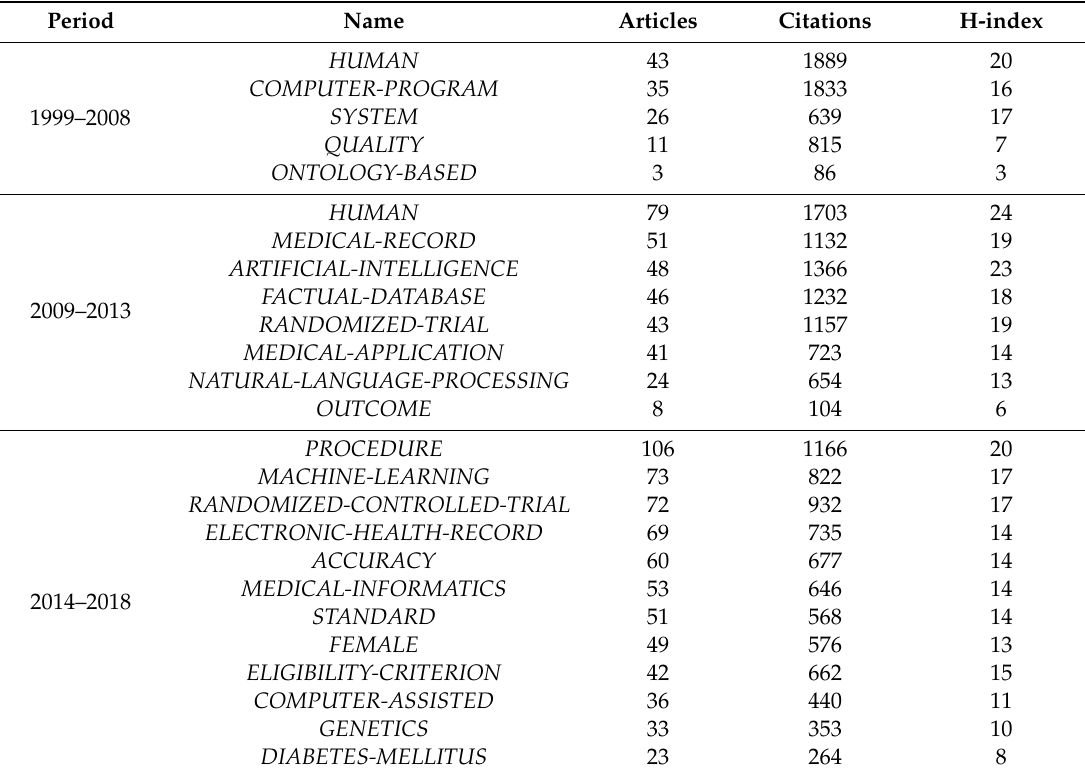
Table 9. Examples of inclusion and exclusion criteria for the manual